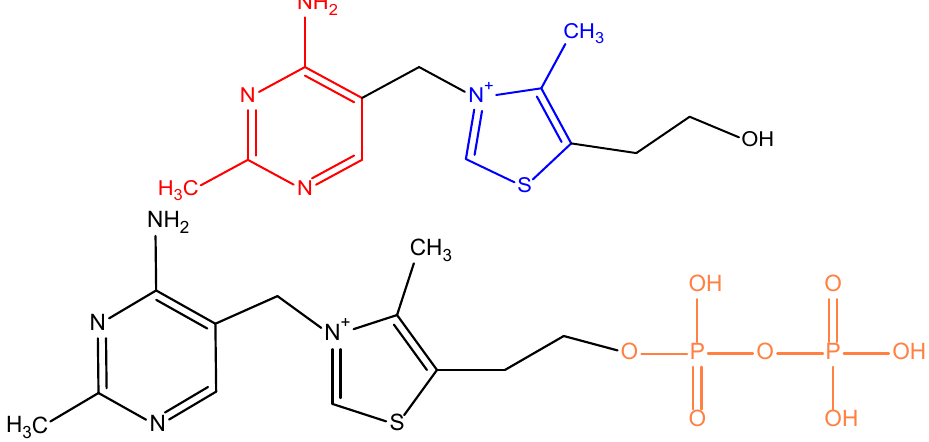
Figure 1. Structure of thiamine (vitamin B 1 (upper)) and thiamine pyrophosphate (TPP (bottom)). Free thiamine is a base that is stable at acidic pH, but it is decomposed by ultraviolet light and gamma irradiation, and it is susceptible to heat. In alkaline solutions, and in the presence of oxidizing agents, thiamine is converted into thiochrome, a fluorescent substance, that is used to determine the vitamin levels in food and drugs [3].